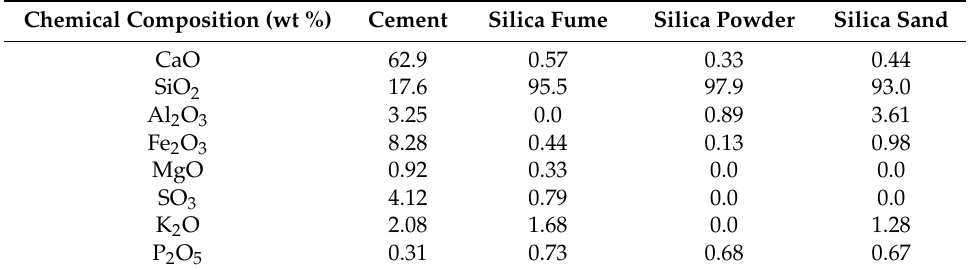
Table 1. Chemical compositions of the used solid constituents determined by X-ray Fluorescence (XRF) analysis.